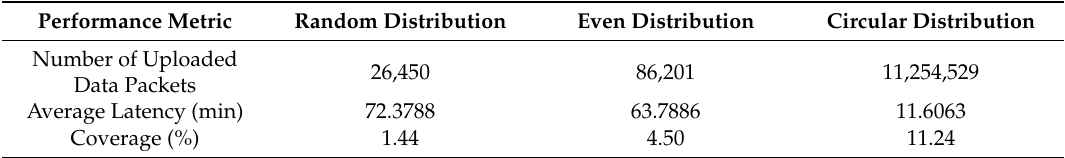
Table 4. Experimental results of LCODC scheme with different locations of data centers.